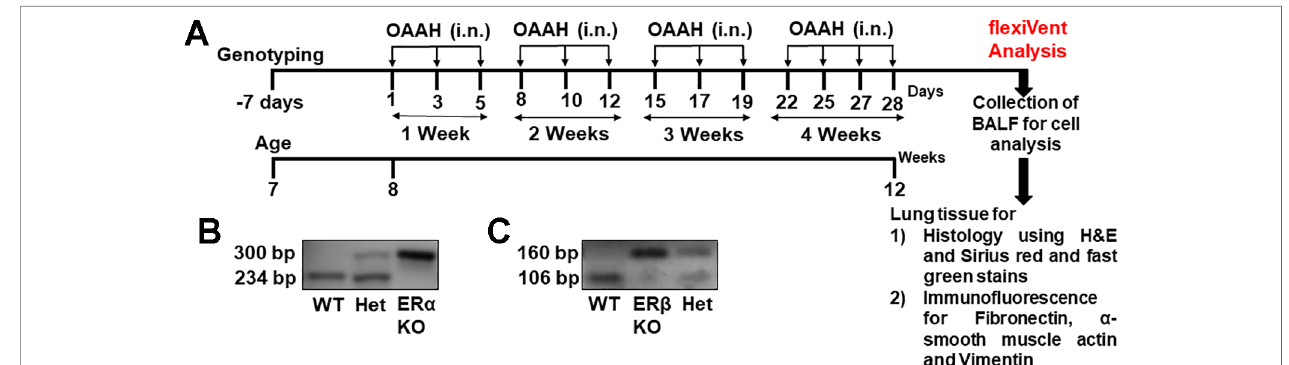
FIGURE 1 | (A) Experimental design of the study. Genotyping was performed at the age of 7 weeks and mice were grouped according to their genotype. Mixed allergen (OAAH: 10 m g each of Ovalbumin, Alternaria Alternata, Aspergillus Fumigatus and Dermatophagoides farinae (house dust mite; i.n., intranasal) was administered on alternate days for 28 days while control mice received phosphate buffer solution as vehicle. (B) Representative image of ER a KO genotyping. (C) Representative image of ER b KO